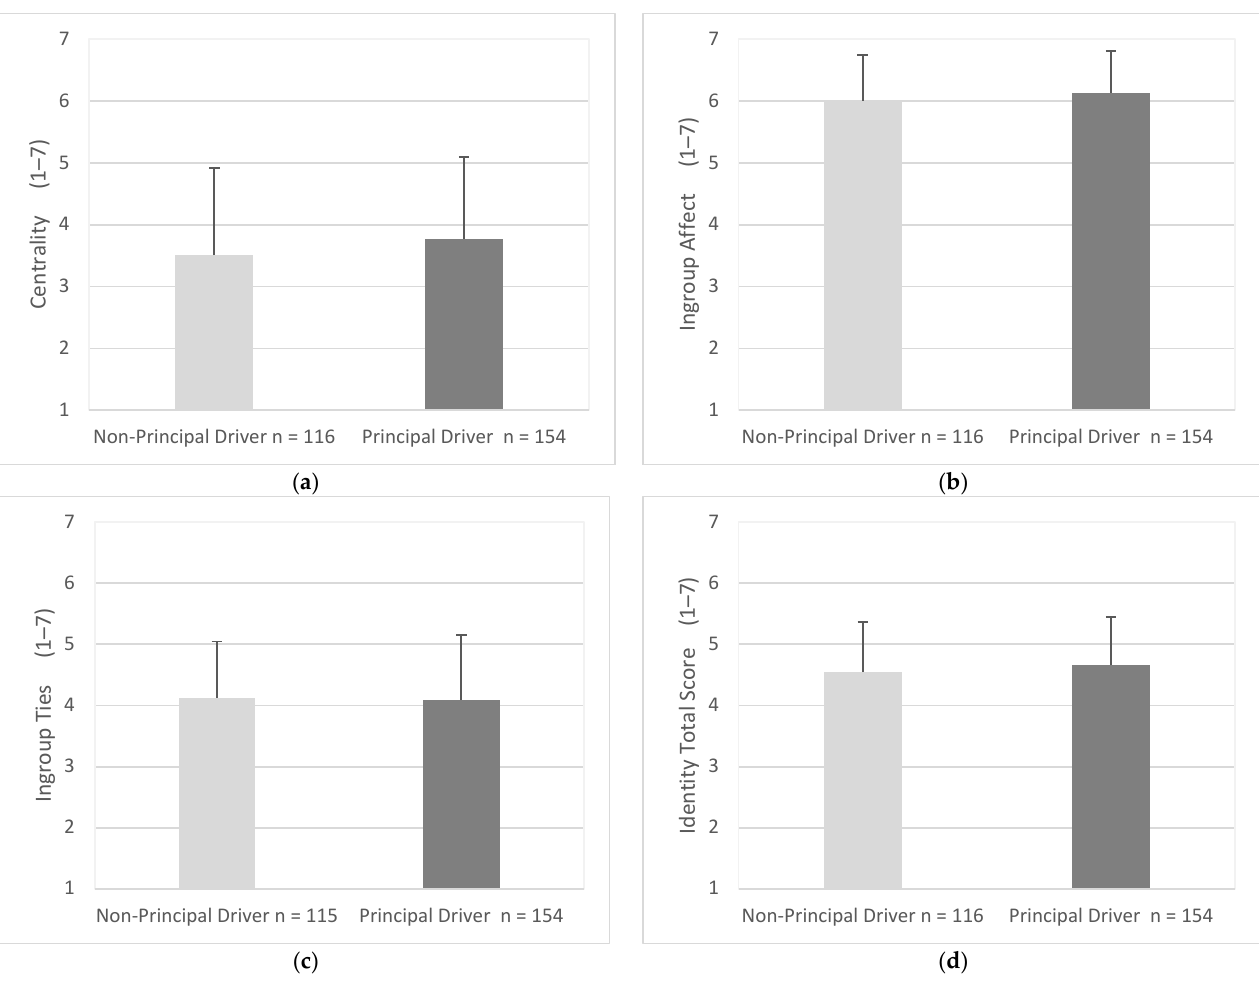
Figure 9. Mean score for identity factors and total scores as endorsed by principal and non-principal drivers. Items were measured using responses of 1 (strongly disagree) to 7 (strongly agree). Error bars represent standard deviation. ( a ) Centrality, ( b ) Ingroup Affect, ( c ) Ingroup Ties, ( d ) Identity Total Score. Total Centrality scores were statistically higher for drivers with low readiness scores ( M = 4.05, SD = 1.30) when compared with drivers with mixed readiness scores ( M = 3.29, SD =1.37), (95% CI, − 0. 50 to 1.03), t (395) = 5.65, p = 0.004 (Figure 10a). Ingroup affect scores were statistically higher for drivers with low readiness scores ( M = 6.15, SD = 0.73) when compared with drivers with mixed readiness scores ( M = 5.99, SD =0.74), (95% CI, 0.01 to 0.30), t (395) = 2.13, p = 0.034 (Figure 10b). Ingroup ties scores were similar for drivers with low readiness scores and mixed readiness scores ( M = 4.17, SD =1.04) ( M = 4.00, SD =0.96), (95% CI, − 0.37 to 0.36), t (394) = − 1.61, p = 0.055 (Figure 10c). Total scores for identity for drivers with low readiness scores were statistically higher ( M = 4.78, SD = 0.76) when com- pared with drivers with mixed readiness scores ( M = 4.43, SD = 0.79), (95% CI, − 0.21 to 0.51), t (395) = 4.58, p = 0.004 (Figure 10d).